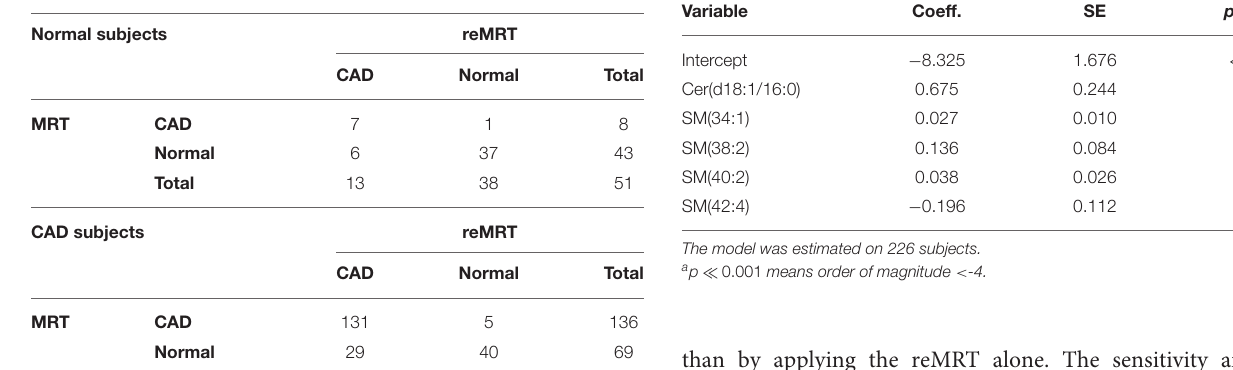
TABLE 4 | Reclassification tables between the minimal risk tool (MRT) original model and the re-estimated model (reMRT) on the SMARTOOL cohort. Normal subjects